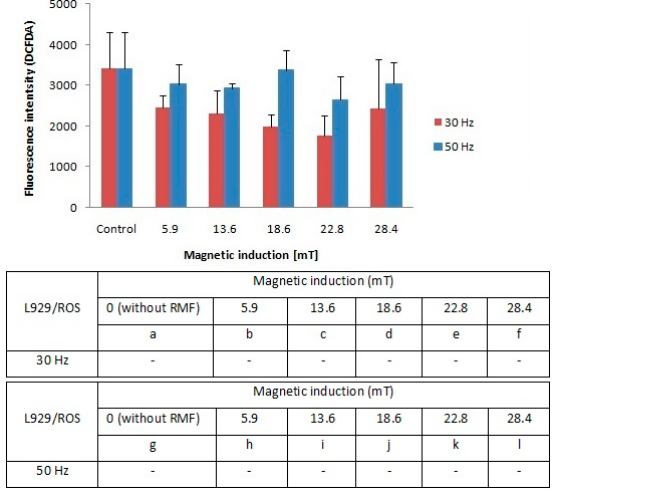
Figure 3. ROS accumulation (fluorescence intensity; DCFDA) in L929 ( a ) and HaCaT ( b ) cell cultures after 4-hour expo- sition to different magnetic induction and frequency of RMF (all samples were compared to control; p -values ˂ 0.05 were considered significant and were represented by small letters).